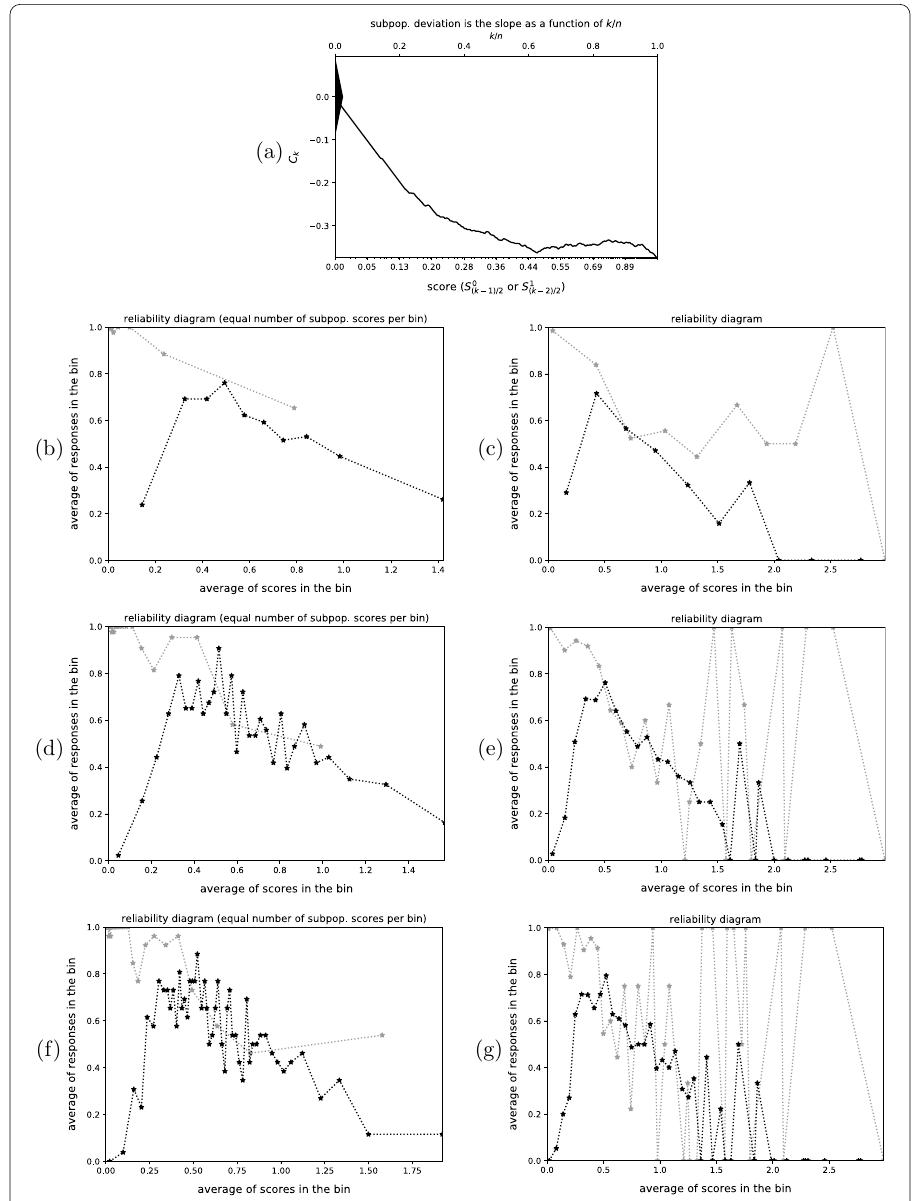
Fig. 7 Eskimo Dog (or Husky) vs. Cheetah (Acinonyx jubatus); n = 455; Kuiper’s statistic is 0.3738 /σ = 7.974 , Kolmogorov’s and Smirnov’s is 0.3738 /σ = 7.974 ; in this case, the reliability diagrams with many bins can resolve the phenomena displayed in the graph of cumulative differences ( a ), but only by sacrificing confidence in their estimates, as they exhibit wild fluctuations. The metrics of Kuiper and of Kolmogorov and Smirnov both report extremely statistically significant deviations between the